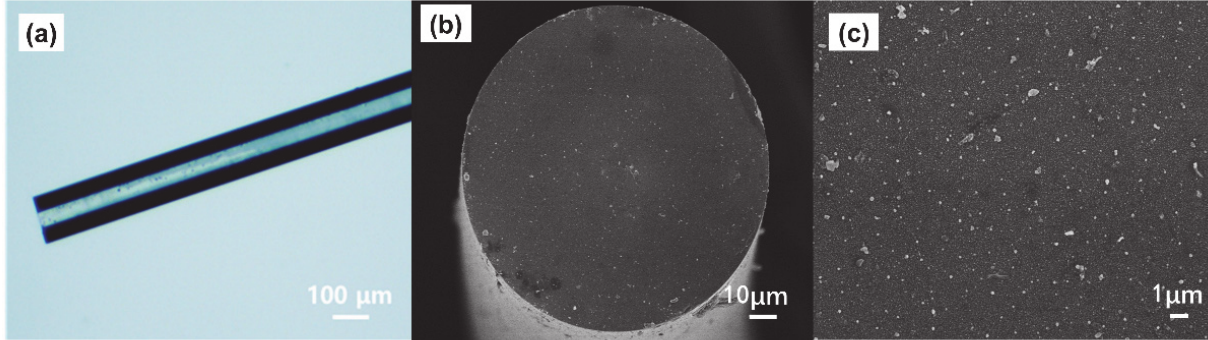
Figure 5. The digital image of SERS fiber probe ( a ), and SEM image of SERS probe with Au-Ag alloy. Nanostars on the terminal end ( b ). The amplification image ( c ).